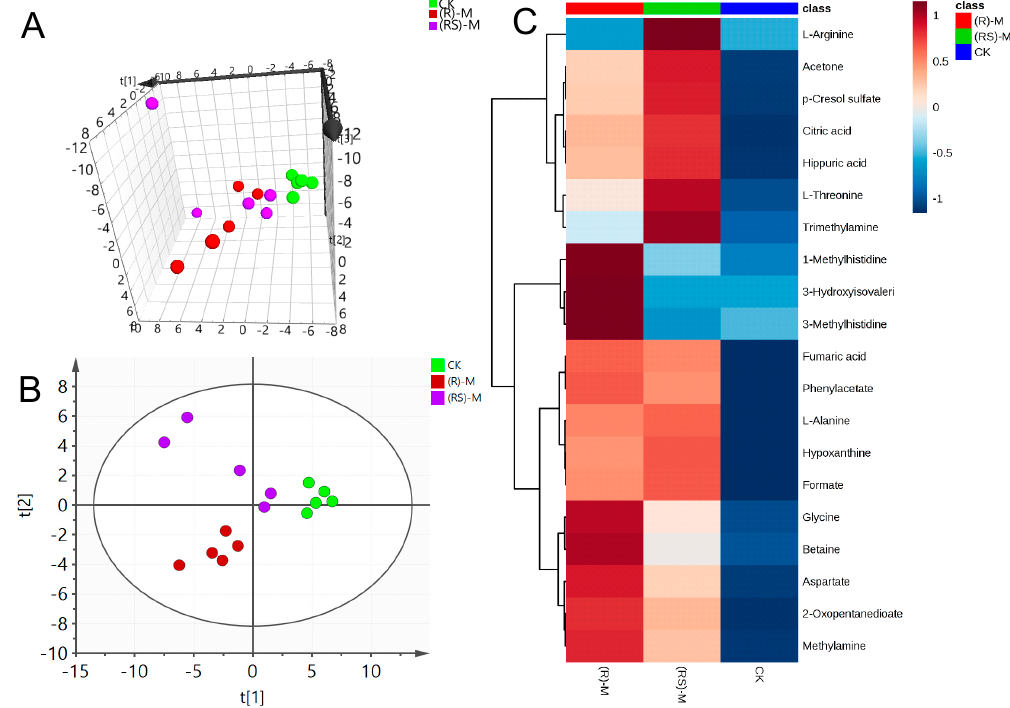
Figure 2. ( A ) Plots for PCA score, ( B ) Plots for PLS-DA score and ( C ) heat map of earthworm metabolites after exposure to medium (5.0 mg/kg) concentration of metalaxyl or metalaxyl-M. (RS)-M: 5.0 mg/kg Metalaxyl, (R)-M: 5.0 mg/kg Metalaxyl-M.